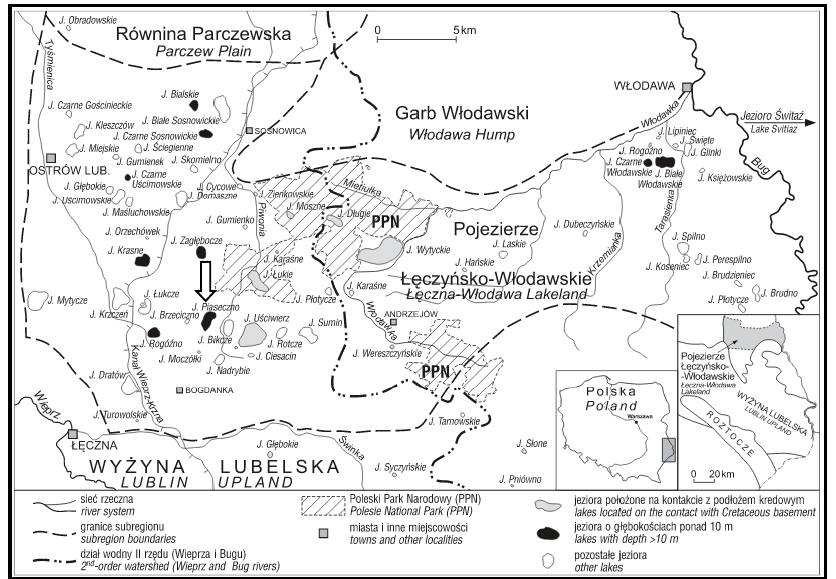
Figure 1. The location of Lake Piaseczno (white arrow) in the Ł˛eczna-Włodawa Lake District. Adapted from [32].